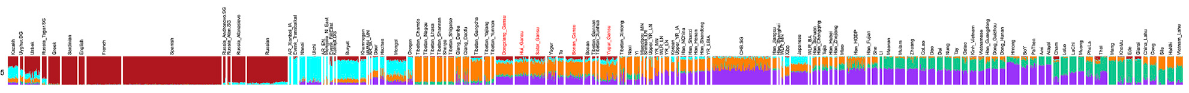
FIGURE 4 | ADMIXTURE analysis result visualization at K (cid:1) 5 as the corresponding cross-validation error was the lowest. And our studied populations in Gansu were marked by red